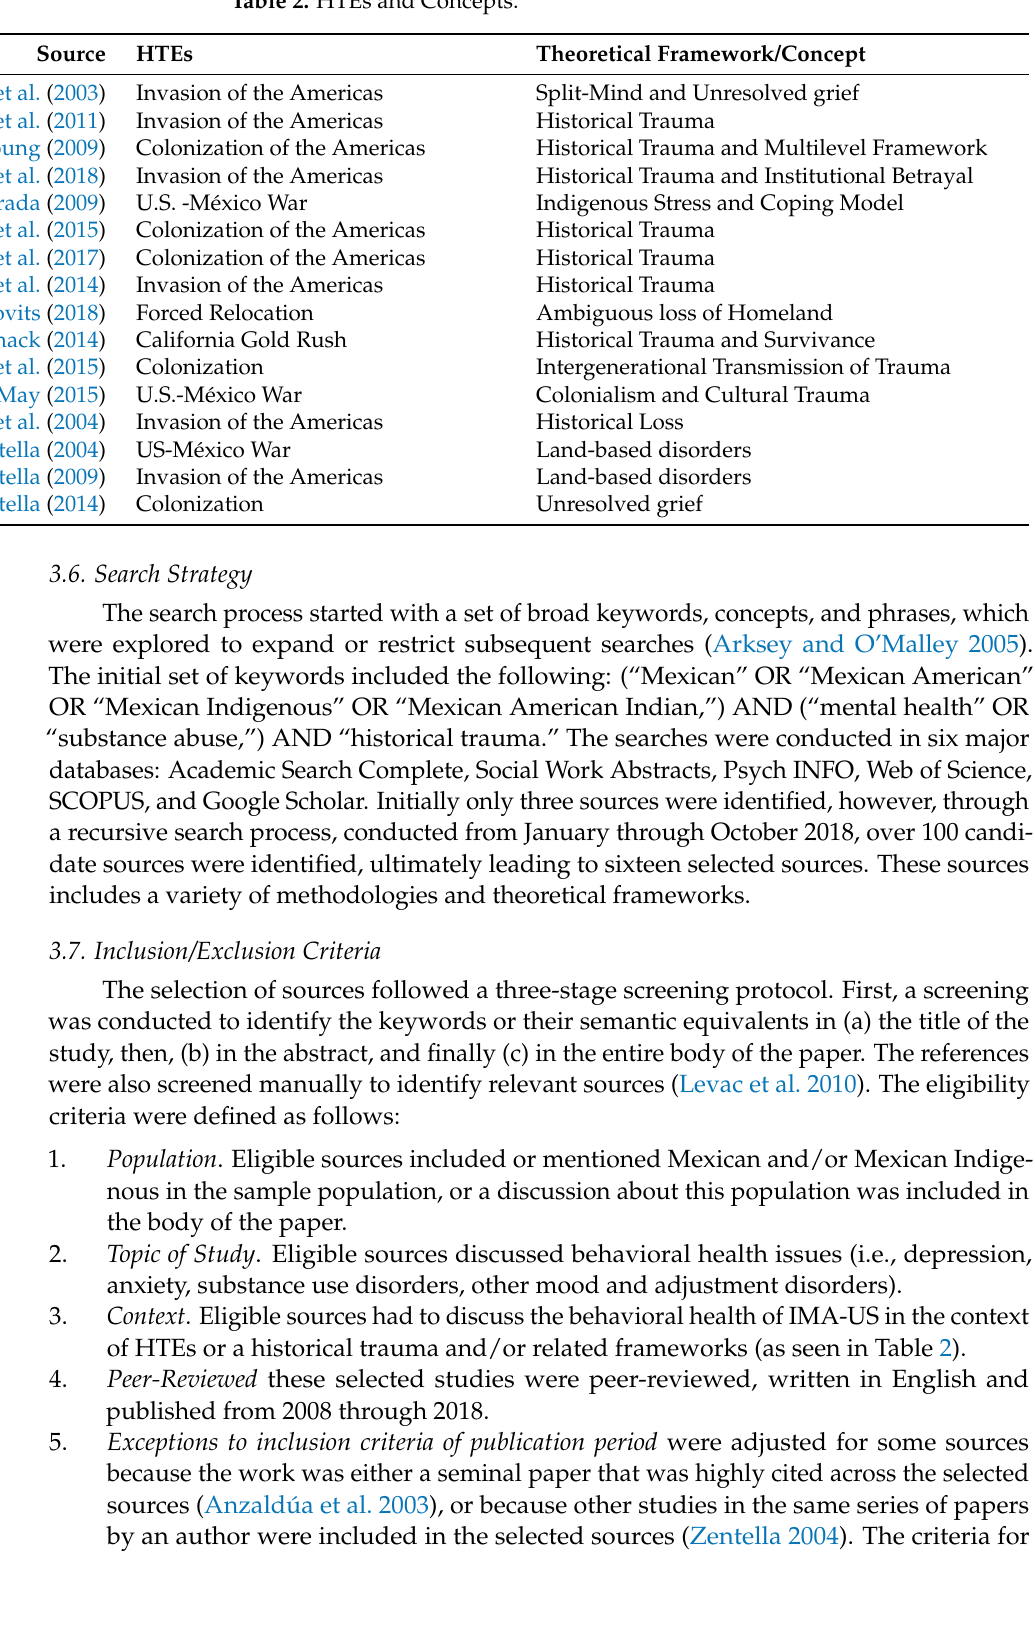
Table 2. HTEs and